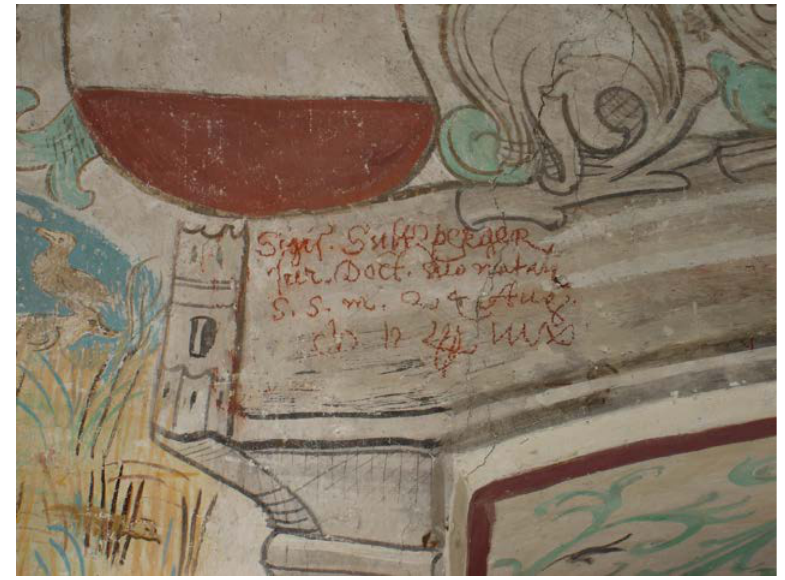
Figure 1 – The graffito by Sigismund Sultzperger in Frundsberg Castle, Schwaz, Northern Tyrol. Photo by Romedio Schmitz-Esser. Courtesy of the